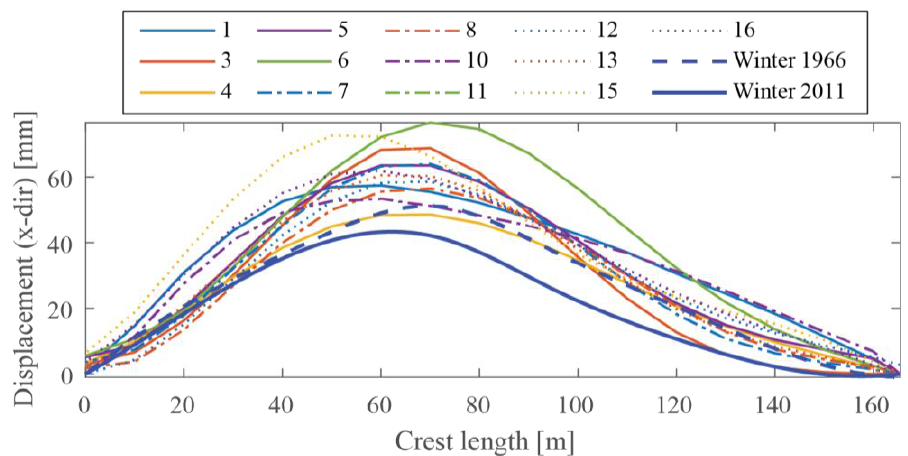
Figure 11. The c alculated displacement along the dam crest during winter conditions based on non- Figure 11. The calculated displacement along the dam crest during winter conditions based on linear analyses, according to the contributors. non-linear analyses, according to the